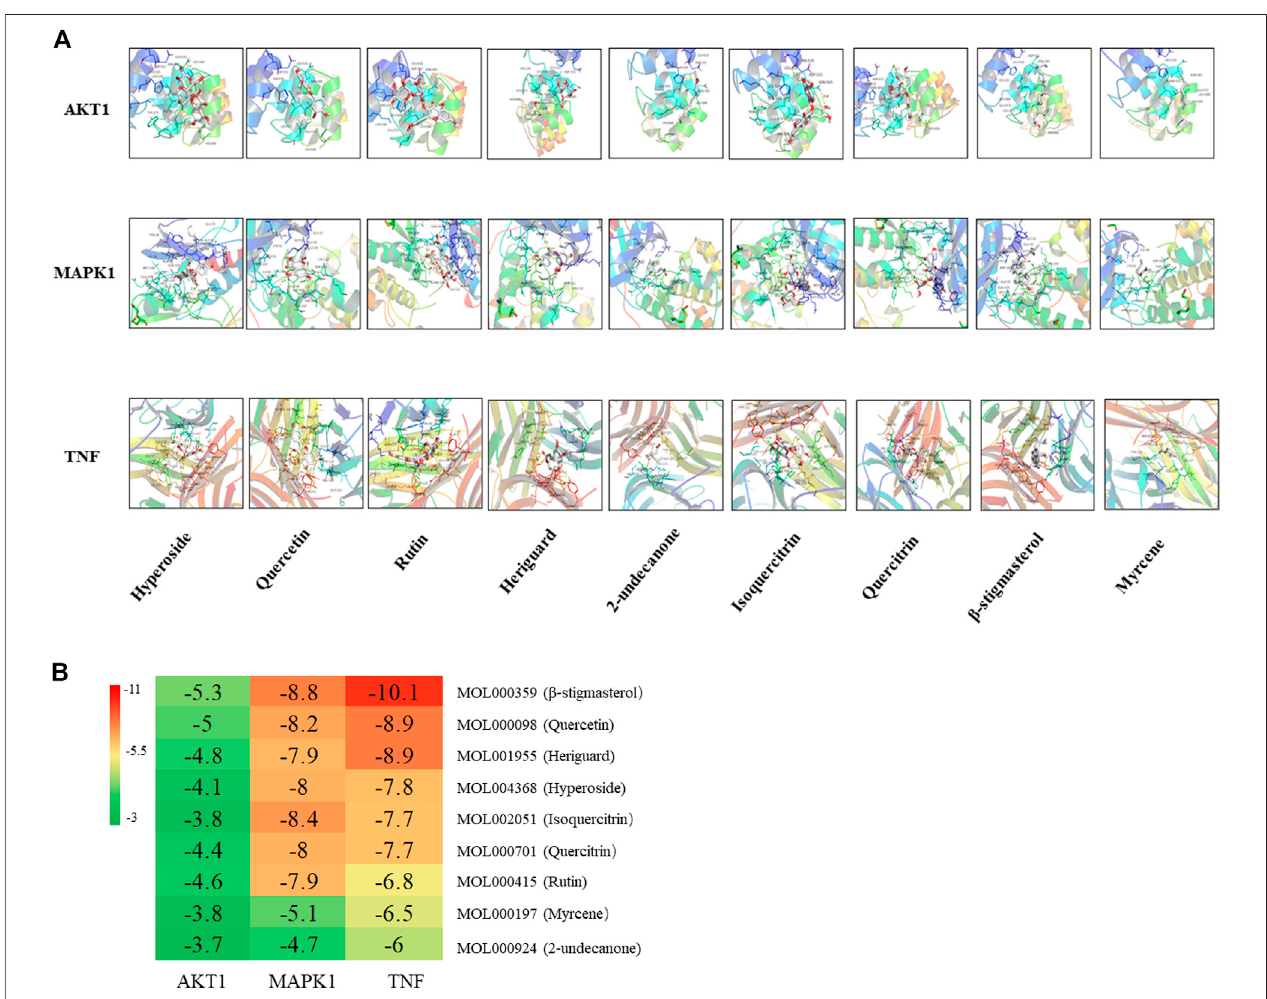
FIGURE 8 | (A) Molecular docking results of the “ bioactive compound-target gene. ” (B) Heatmap of the docking scores of the main chemical constituents of H. cordata and the target